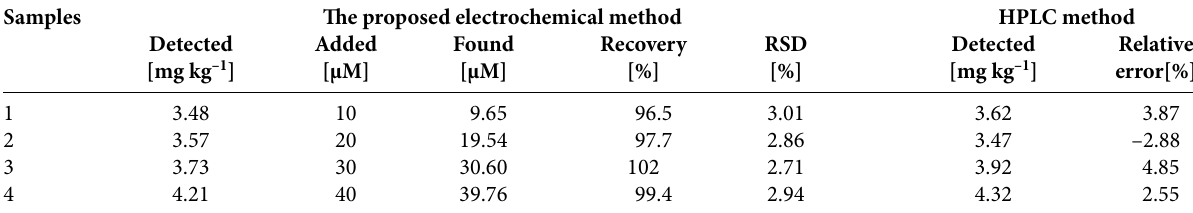
Table 2. Results of the determination of nitrite in pickles (n = 4). Samples The proposed electrochemical method HPLC